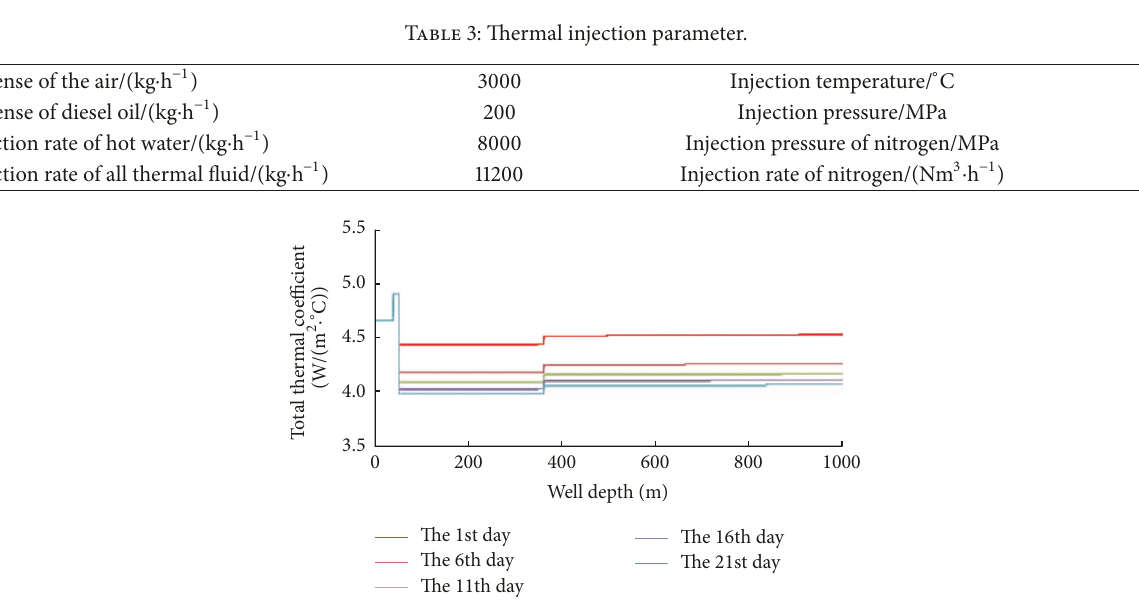
Figure 2: Total thermal coefficient along